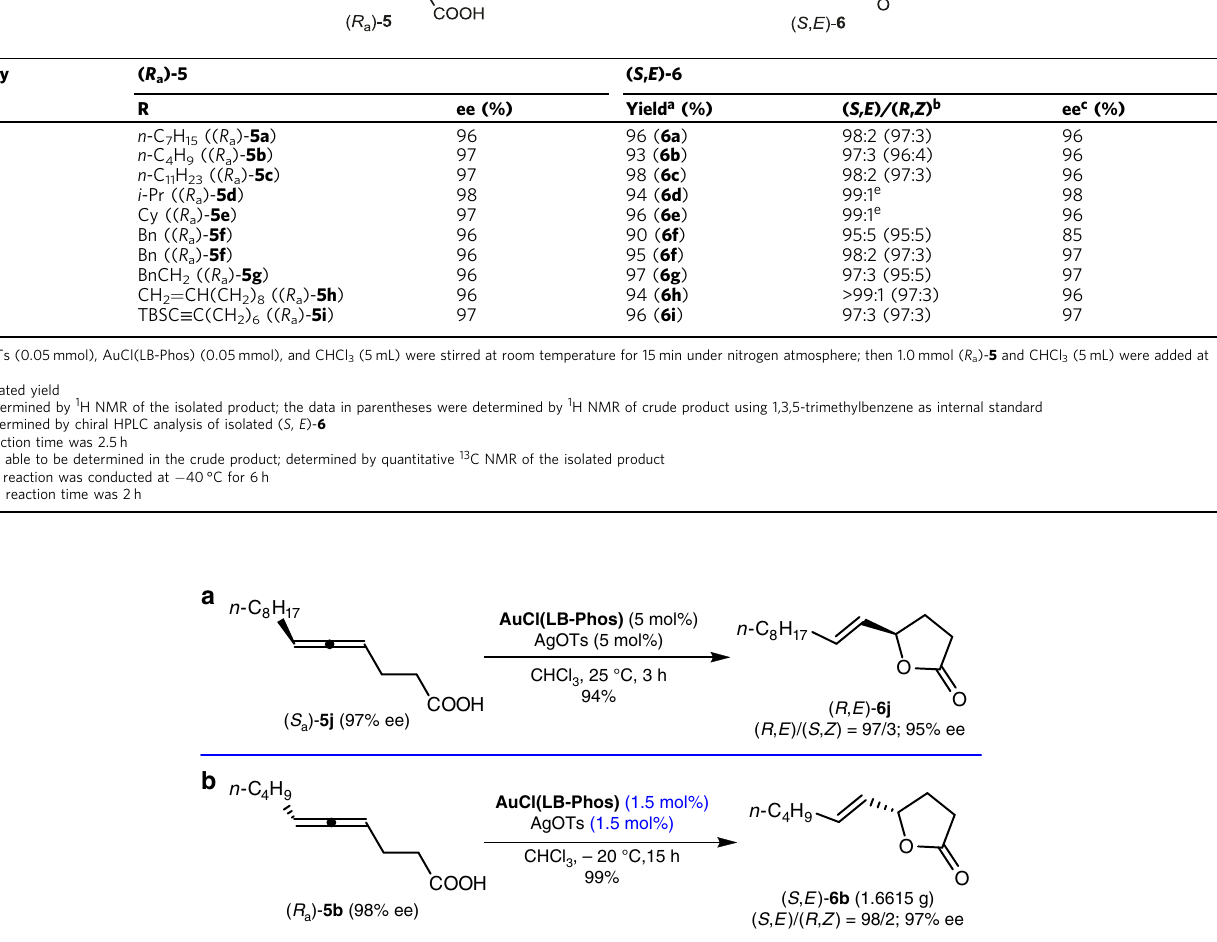
Fig. 4 Extended scope of Au-catalyzed cycloisomerization reaction. a Synthesis of the enantiomer ( R , E )-butyrolactone 6j ; b Gram scale synthesis for γ - butyrolactone ( S , E )-